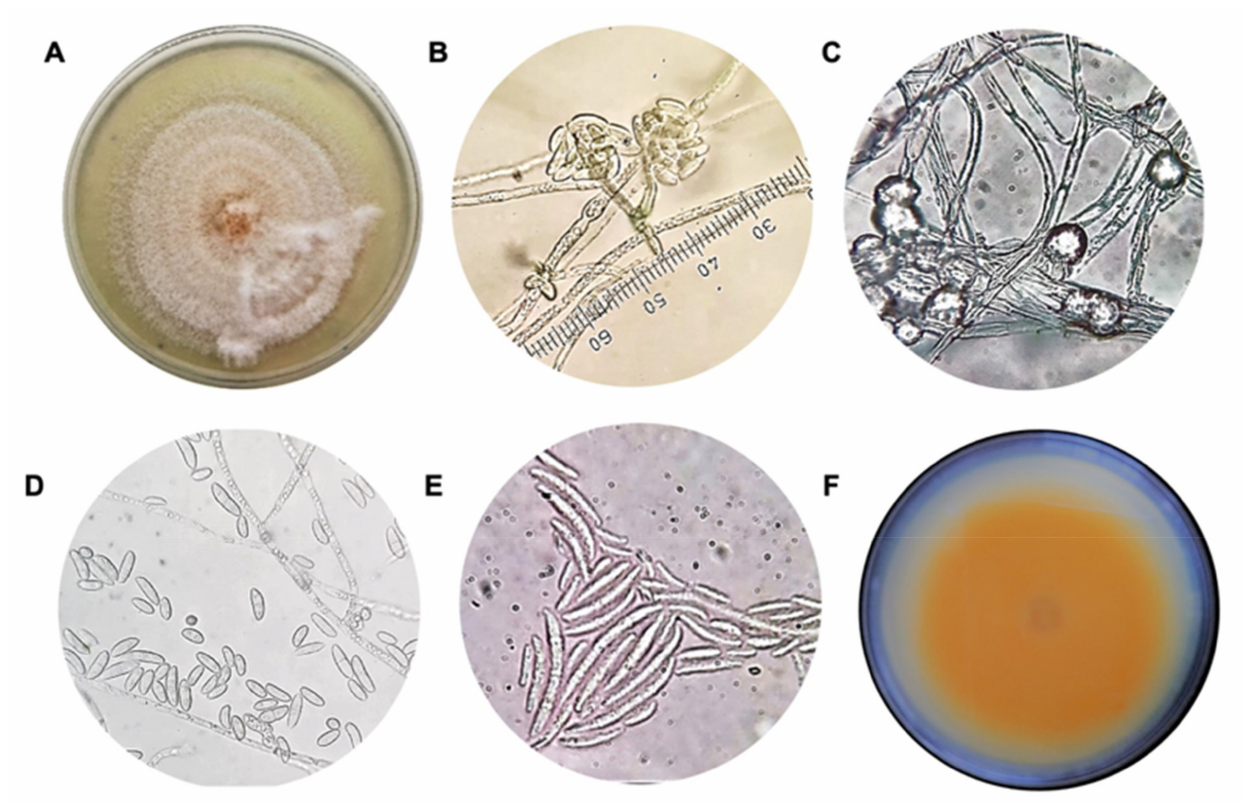
Figure 1. Morphology of the MA-FC120 strain: ( A ) Appearance of colony on PDA culture medium; ( B ) False heads of microconidia held in monophialides seen at 40 × and 1000 × ; ( C ) Chlamydospora seen at 1000 × ; ( D , E ) microconidia and macroconidia seen at 400 × and 100 × , respectively; ( F ) Colony reverse staining on